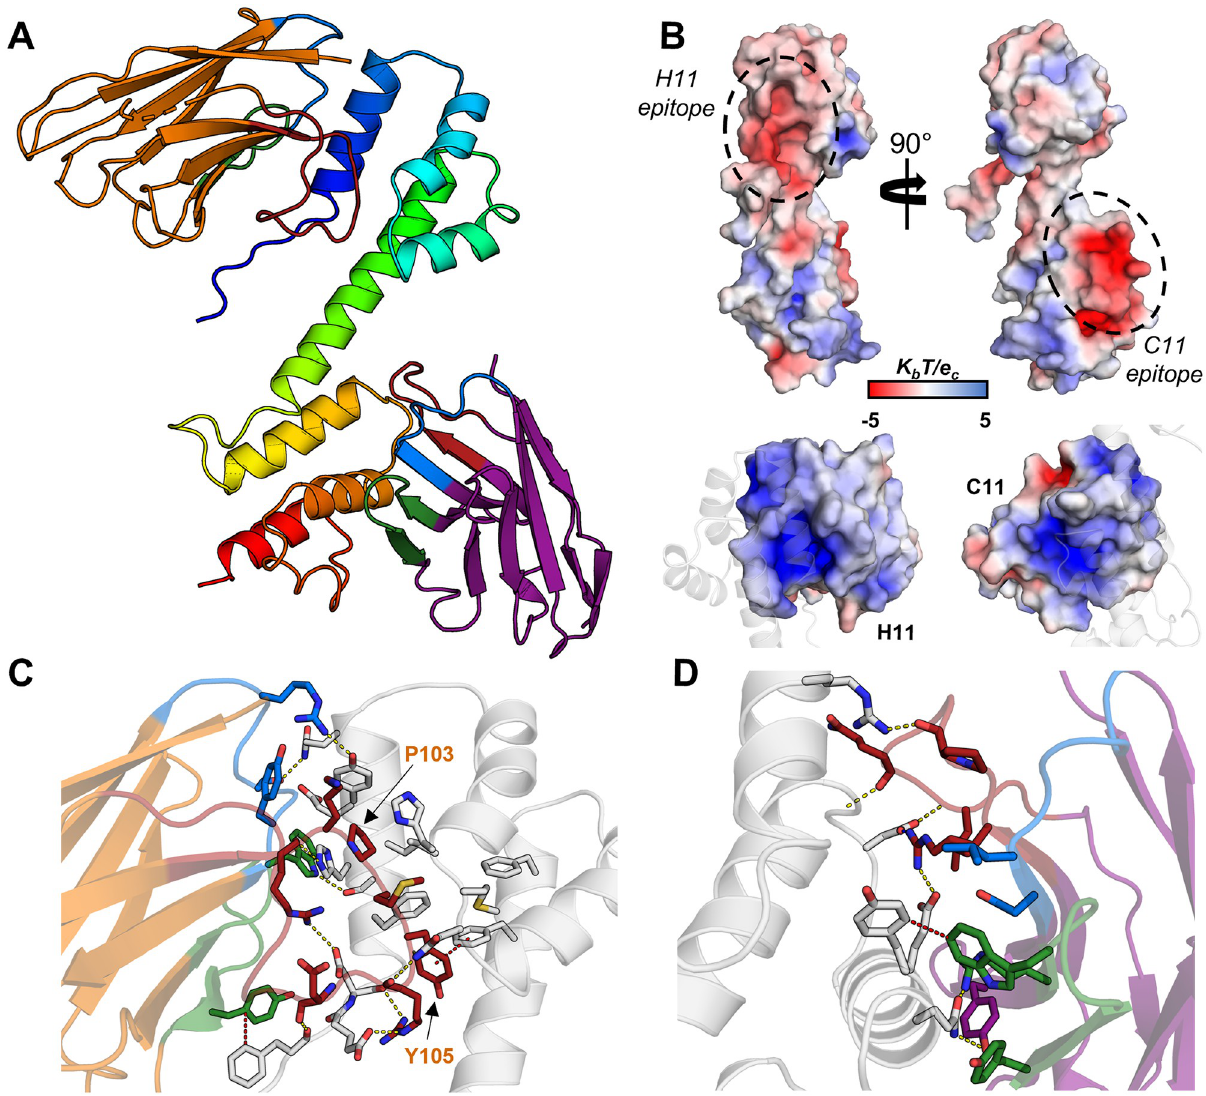
Fig 7. The crystal structure of rArc-CTD in complex with NbArc-H11 and -C11. A The overall structure. The CTD of rArc is shown in blue to red from the N- to the C-terminus. NbArc-H11 is shown in orange and NbArc-C11 in purple. CDR 1, 2, and 3 are coloured blue, green, and red, respectively. B Both Nbs bind acidic surface patches of the CTD (above); the surface of the Nb CDRs is positive (below). Electrostatic potential was calculated using ABPS [76]. The epitopes correspond to the ligand peptide binding site of the N-lobe (H11) and the C-lobe oligomerisation surface (C11). C Pro103 and Tyr105 of H11 extend into the Arc N-lobe hydrophobic pocket. D C11 binding of the rArc-CTD. Polar contacts (yellow) and π - π interactions (red) are indicated with dashes.